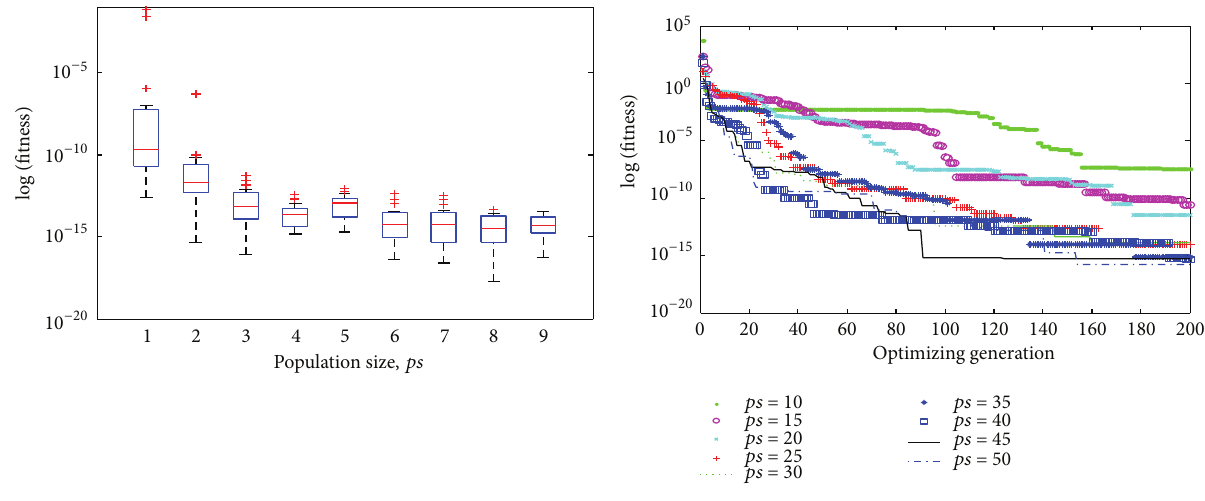
Figure 3: Box-and-whisker diagram and iterative curve about the impact of different population size 𝑝𝑠